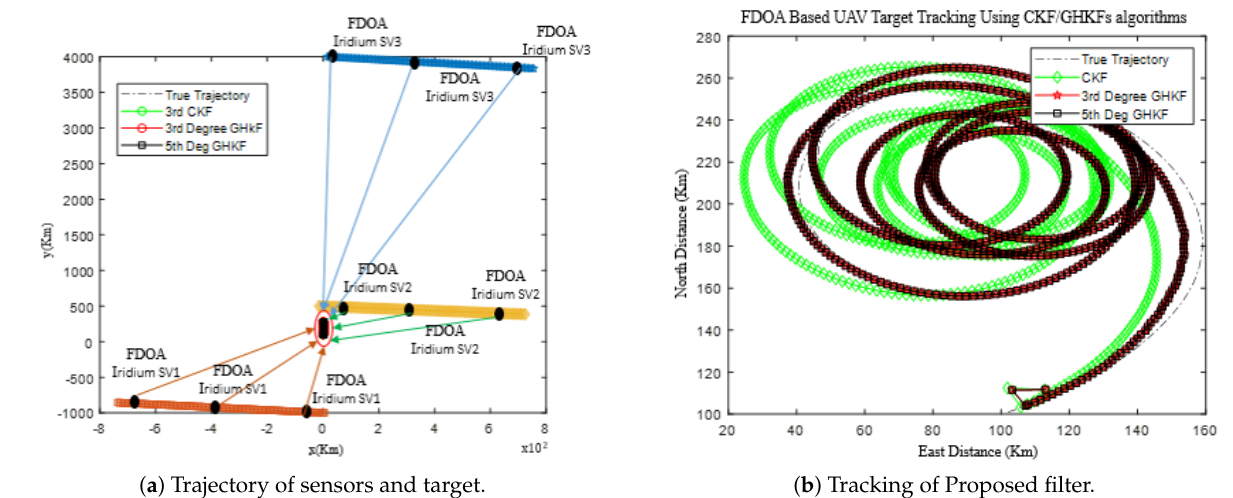
Figure 30. Three (03) Iridium satellites were employed to track a UAV based on an FDOA measurement. Authors’ own elaboration.